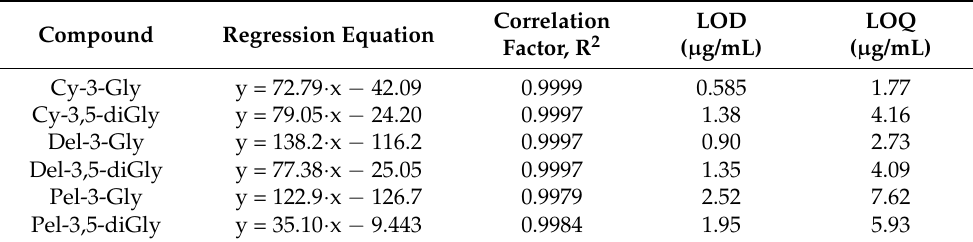
Correlation Factor, R 2